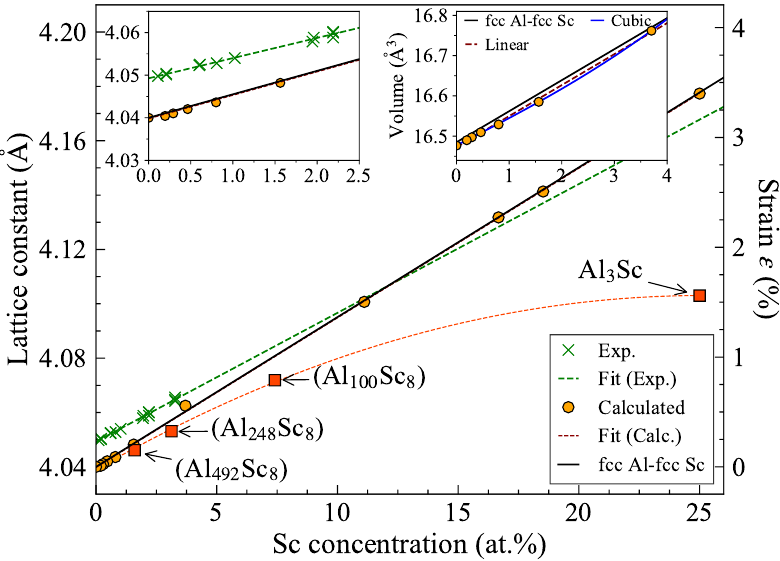
Figure 3. Variation of lattice parameter of substitutional Sc solid solution with Sc concentration in fcc Al. The symbols represents the calculated (orange circles: solid solution, red squares: L 1 2 ordering of Sc atoms) and the measured (green crosses) data points [91]. The dashed lines are fits to the respective data points. The black (solid) line represents the linear interpolation between fcc Al and fcc Sc lattice parameters (Vegard’s law). The left inset provides a zoom into low concentrations. The right inset shows the interpolation for the concentration dependence of the volume (per atom) of the substitutional solid solution (black line: Retger’s law). The figure has been taken from [43]. The low solubility of Sc in Al ( 10 − 10 at.% at room temperature and 0.26 at.% at 934 ≈